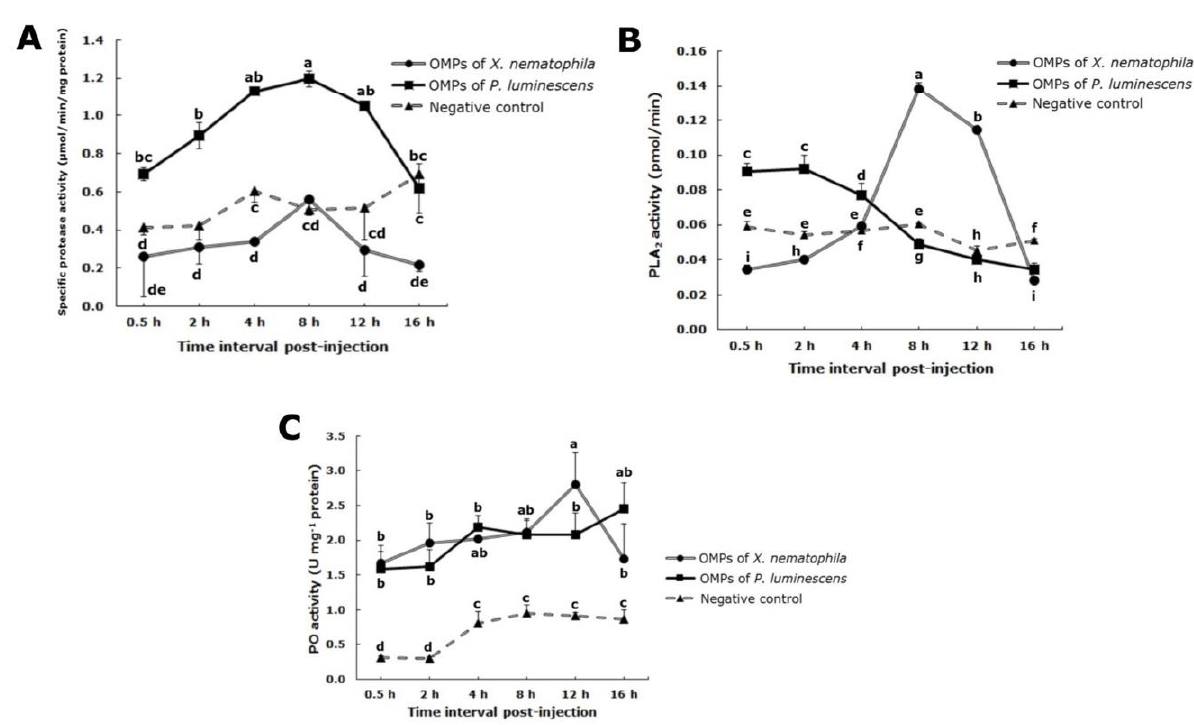
Figure 3. Changes in the patterns of humoral defense elements in fifth instar larvae of Spodoptera exigua after injection with outer membrane proteins of Xenorhabdus nematophila or outer membrane proteins of Photorhabdus luminescens , ( A ) protease, ( B ) phospholipase A2, ( C ) phenoloxidase. Each measurement consists of eight replications. The vertical bars represent the standard error of the means. Different letters above the error bars indicate a significant difference of interactive effect means between outer membrane proteins from the two bacterial species × interval times at α = 0.05 (Slicing test).